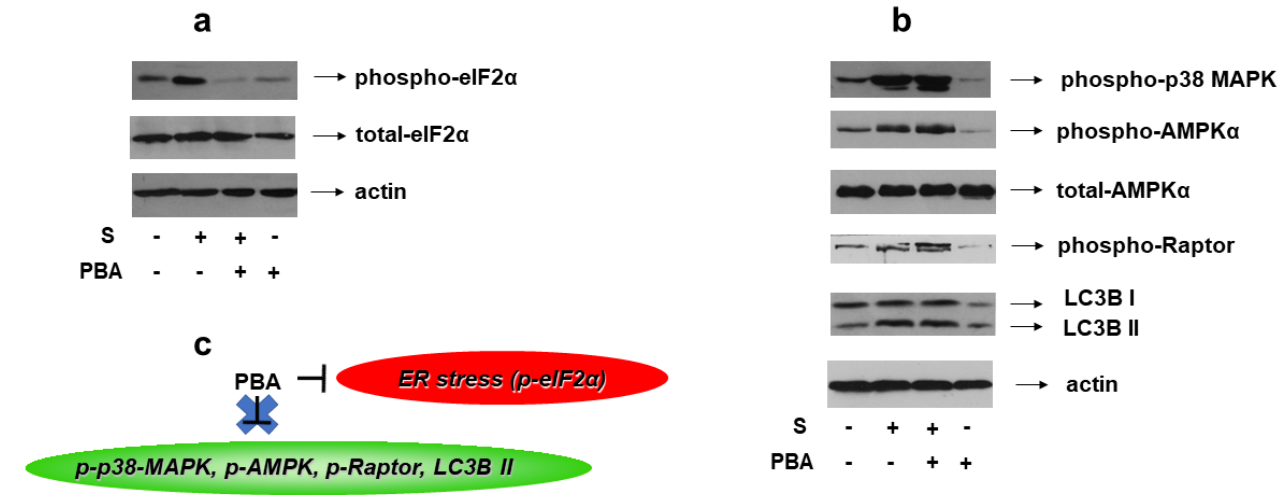
Figure 12. Effect of ER stress inhibition on hyperosmotic-stress-induced responses in H9c2 cells. H9c2 cells were left untreated or were incubated with PBA alone, or with PBA followed by exposure to 0.5 M sorbitol in the presence of PBA. Cell extracts (40 μ g/lane) were subjected to SDS-PAGE and immunoblotted with antibodies against phosphorylated eIF2 α (( a ) upper panel), total levels of eIF2 α (( a ) second panel), phosphorylated p38-MAPK (( b ) upper panel), phosphorylated AMPK α (( b ) 2nd panel from top), total levels of AMPK α (( b ) 3rd panel from top), phosphorylated Raptor (( b ) 4th panel from top) and endogenous levels of total LC3B protein (LC3 I and LC3 II forms) (( b ) 5th panel from top). Equal protein loading was verified by immunoblotting identical samples with a specific anti-actin antibody (( a , b ) bottom panels). Western blots are representative of at least three independent experiments with overlapping results. ( c ) Schematic representation of the effect of ER stress inhibition by PBA under hyperosmotic stress conditions: PBA (an ER stress inhibitor evidenced by suppression of eIF2 α phosphorylation) does not modify the phosphorylation status of p38-MAPK, AMPK or Raptor, nor the LC3B II / LC3B I ratio.